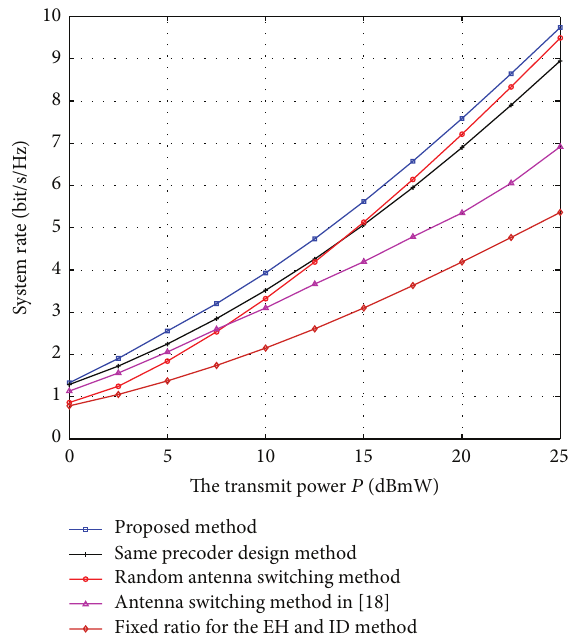
Figure 3: Achievable sum rate of the SWIPT relay network for different relay position (total transmit power 𝑃 = 20